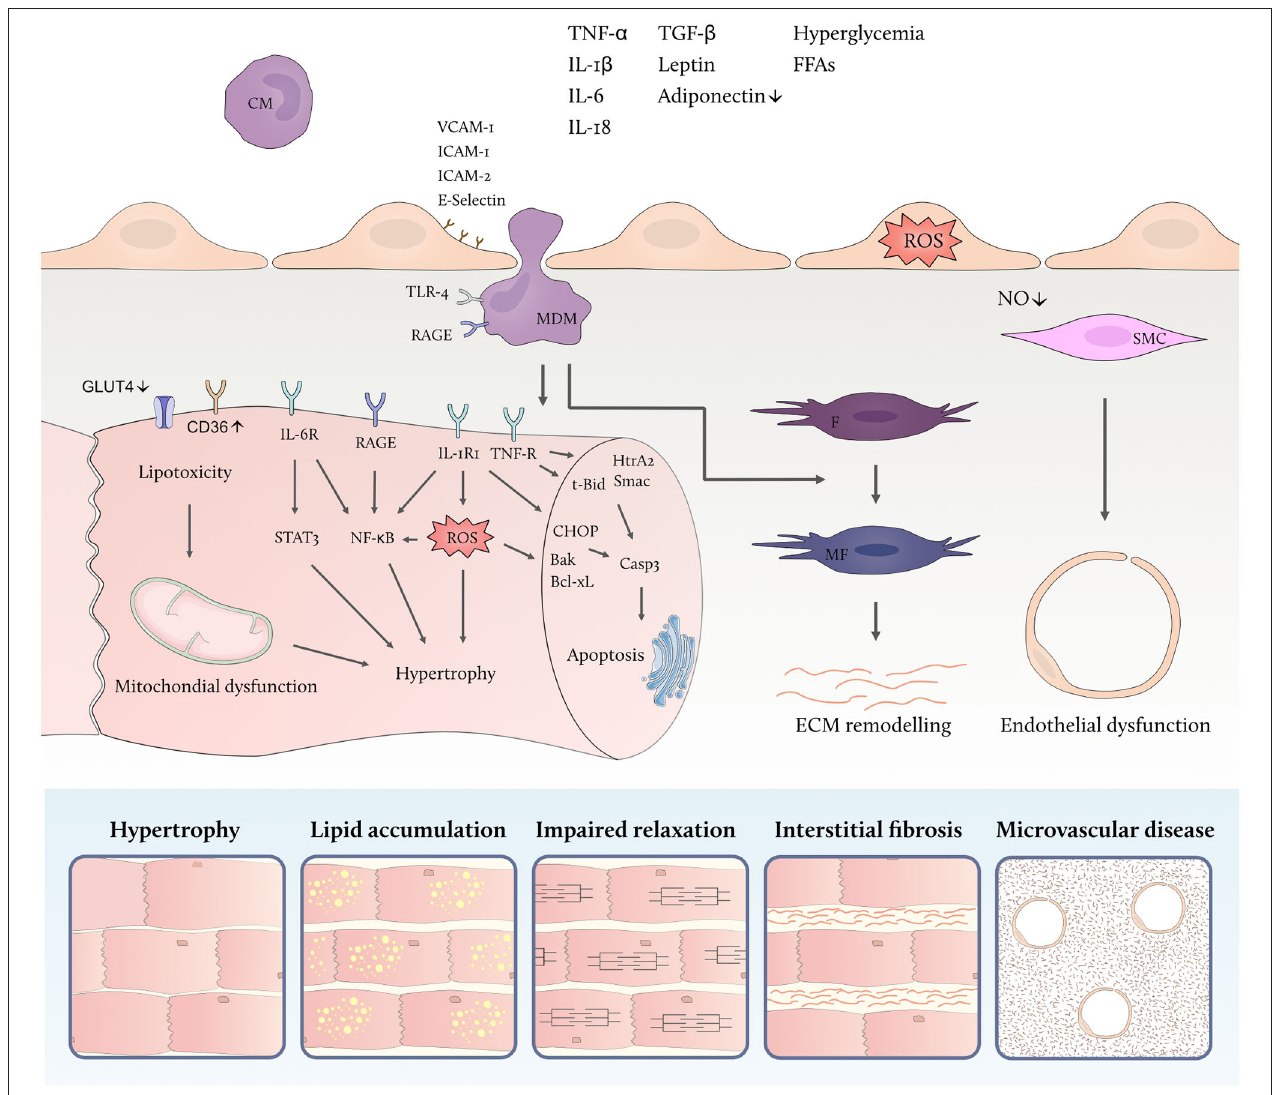
FIGURE 2 | Metabolic inflammation promotes myocardial remodeling. High levels of circulating inflammatory cytokines and metabolic substrates activate inflammatory cascades in different cardiac cell types linked to cellular dysfunction. Endothelial activation facilitates leucocyte adhesion and transmigration into the myocardium thereby aggravating the low-grade inflammatory state. Both free fatty acids (FFAs) and high glucose levels modulate the polarization of monocyte-derived macrophages (MDM) which secrete inflammatory and profibrotic cytokines. Cardiac insulin resistance is promoted by inflammatory cytokines, including tumor necrosis factor alpha (TNF- α ), and goes along with down-regulation of the insulin-dependent glucose transporter 4 (GLUT4) and upregulation of the fatty acid transporter cluster of differentiation (CD)36 thus contributing to lipotoxicity, mitochondrial dysfunction and accumulation of reactive oxygen species (ROS). In addition, direct effects of circulating inflammatory mediators lead to endothelial ROS formation and microvascular dysfunction. IL denotes interleukin; IL-1RI, IL-1 receptor type I; IL-6R, IL-6 receptor, TNF-R, TNF receptor; STAT3, signal transducer and activator of transcription 3; NF- κ B, nuclear factor kappa-light-chain-enhancer of activated B cells; HtrA2, HtrA serine peptidase 2; Smac, second mitochondria-derived activator of caspase; t-Bid, truncated BH3 interacting domain death agonist; CHOP, C/EBP homologous protein; Bak, BCL2-antagonist/killer; Bcl-xL, BCL-extra-large; Casp3, caspase 3; TGF- β , transforming growth factor beta; VCAM-1, vascular cell adhesion molecule 1; ICAM, intercellular adhesion molecule; RAGE, receptor for advanced glycation end products; IL-R, interleukin receptor; CM, circulating monocyte; MDM, monocyte derived macrophage; F, fibroblast; MF, myofibroblast; SMC, smooth muscle cell; ROS, reactive oxygen species; NO, nitric oxide; ECM, extracellular